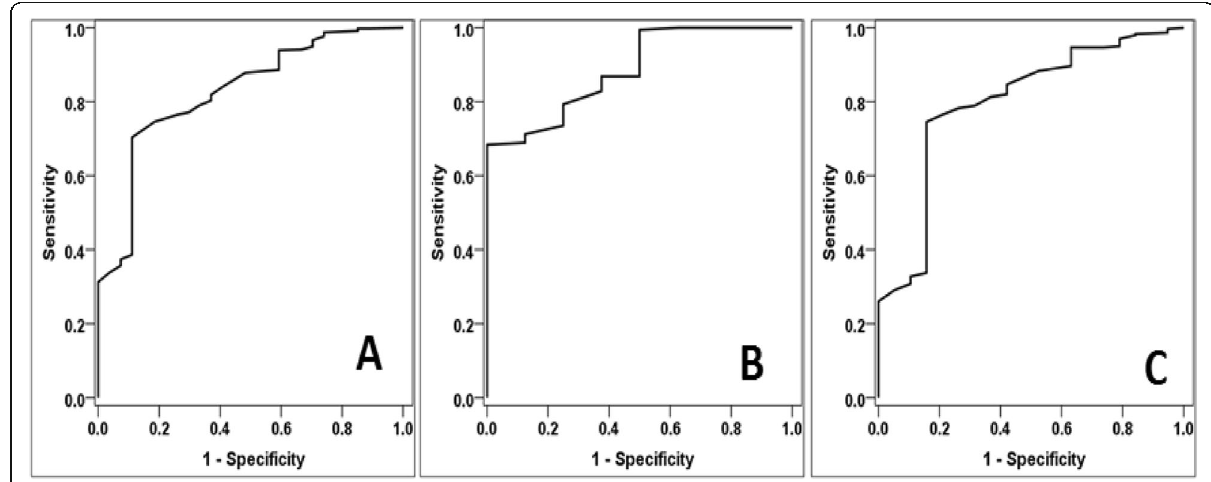
Fig. 1 ROC curve for COVID-19 anxiety score in diagnosing anxiety [25] among all sample, males, and